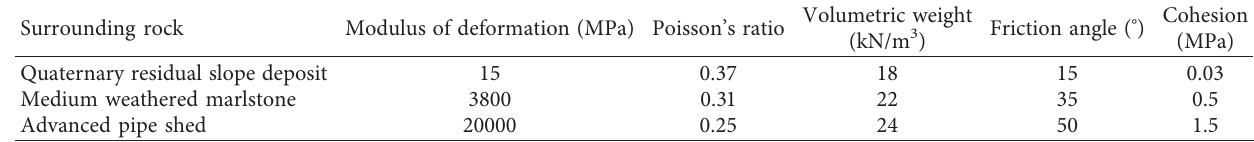
Table 2: Calculation parameters of surrounding